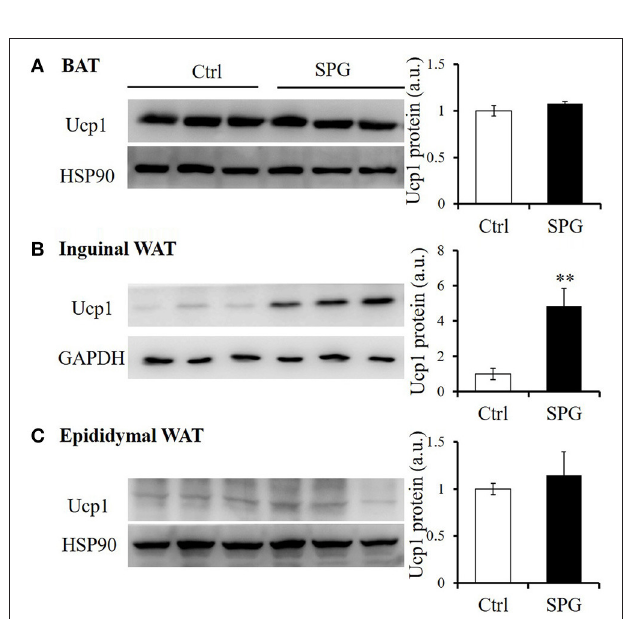
FIGURE 7 | Supaglutide upregulates Ucp1 protein expression in inguinal WAT. Ucp1 protein expression in (A) BAT, (B) inguinal WAT, and (C) epididymal WAT was determined by WB. The bar graph represents quantitative results of 2–3 assays from 5 mice. Significant difference between control and SPG is determined using unpaired Student’s t -test. ** p < 0.01.